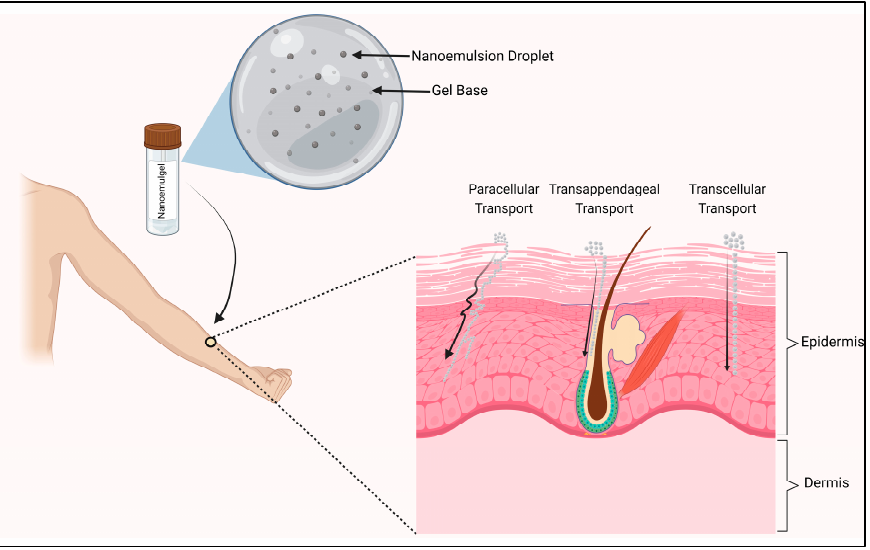
Figure 2 . Mechanistic representation of nanoemulgel delivery via skin. Figure 2. Mechanistic representation of nanoemulgel delivery via